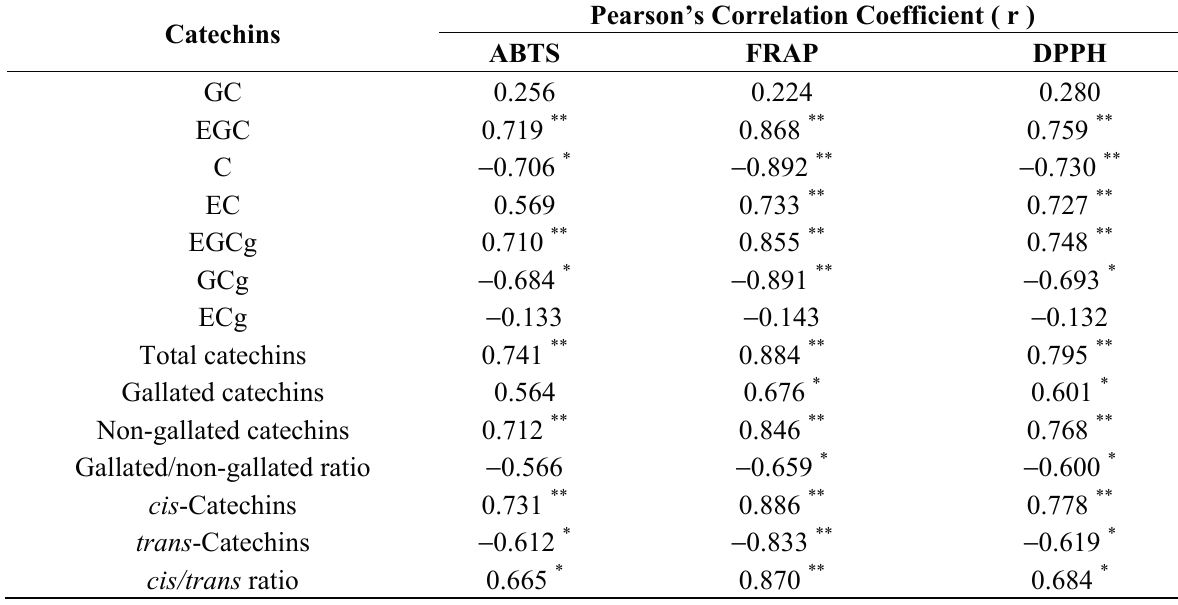
Table 3. Correlations between antioxidant activity and catechins composition of green tea with different plucking